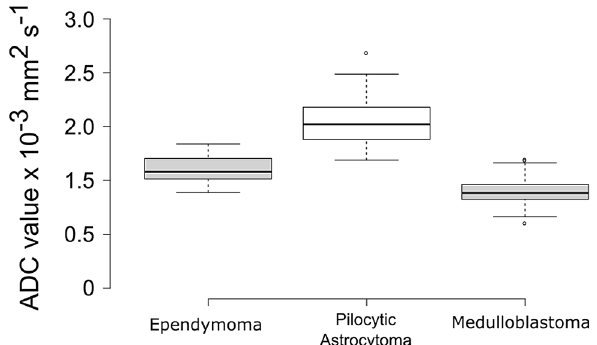
Figure 2. A boxplot showing the distribution of the means from the ADC histograms for Ependymomas, Pilocytic Astrocytomas and Medulloblastomas. Centre lines show the medians; box limits indicate the 25th and 75th percentiles as determined by R software (R Core Team (2017). R: A language and environment for statistical computing. R Foundation for Statistical Computing, Vienna, Austria. URL https ://www.R-proje ct.org/) whiskers extend 1.5 times the interquartile range from the 25th and 75th percentiles, outliers are represented by dots.